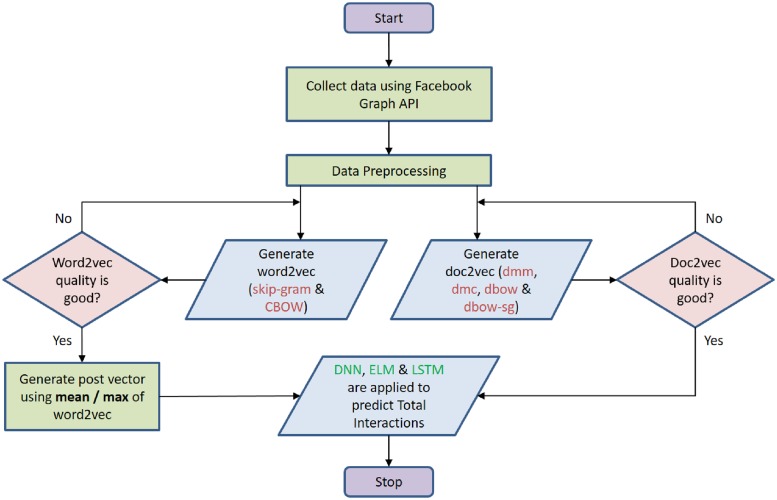
Experiment steps.